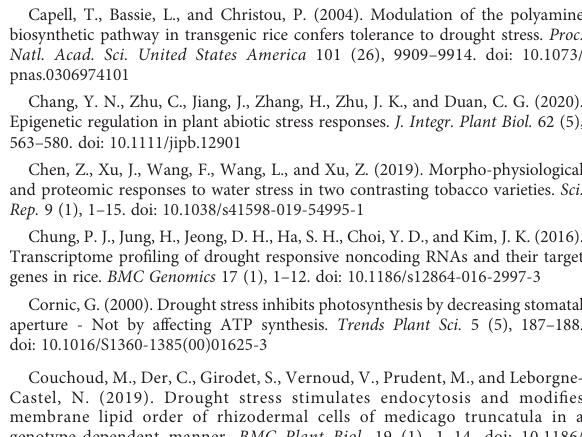
SUPPLEMENTARY TABLE S3 Down-regulated gene list after drought. SUPPLEMENTARY TABLE S4 Up-regulated gene list after drought. SUPPLEMENTARY TABLE S5 Down-regulated gene list in K326 after drought. SUPPLEMENTARY TABLE S6 Down-regulated gene list in M28 after drought. SUPPLEMENTARY TABLE S7 Pathways shared between DEGs and DiffExp